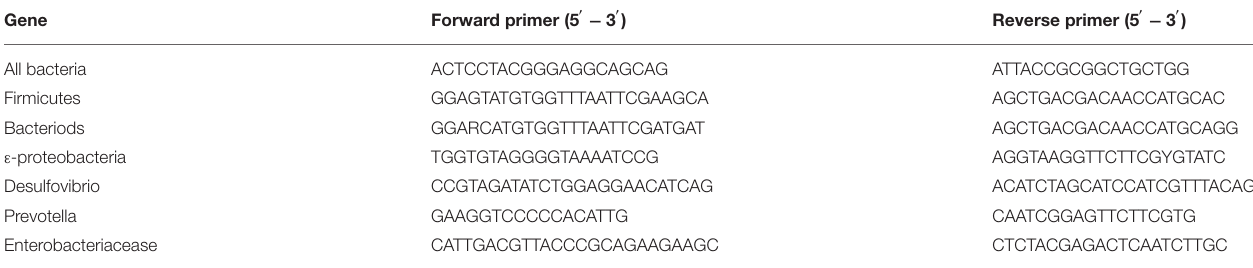
TABLE 2 | The list of 16S recombinant DNA (rDNA) primers for microbiota.